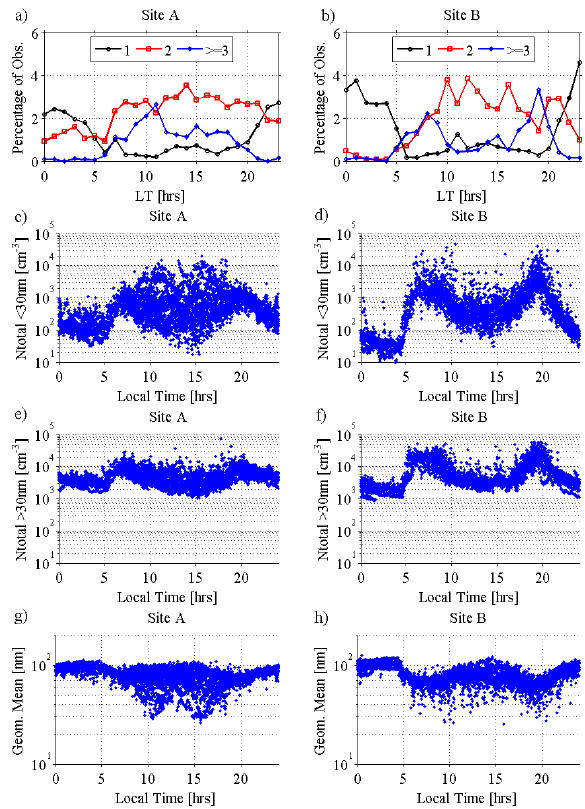
Figure 7: a-b) Diurnal evolution of fitted multi-lognormal distributions over the entire sampling period.]. Fig. 7. (a–b) Diurnal evolution of fitted multi-lognormal distribu- Composite diurnal Cycle of the measured total number concentrations for the entire sampling period c-d) Dp<30 nm and e-f) Dp>30 nm. g-h) Composite diurnal Cycle of the geometric mean diameter of tions over the entire sampling period. Composite diurnal Cycle of measured aerosol size distribution. the measured total number concentrations for the entire sampling period (c–d) Dp < 30nm and (e–f) Dp > 30nm. (g–h) Composite diurnal Cycle of the geometric mean diameter of measured aerosol size